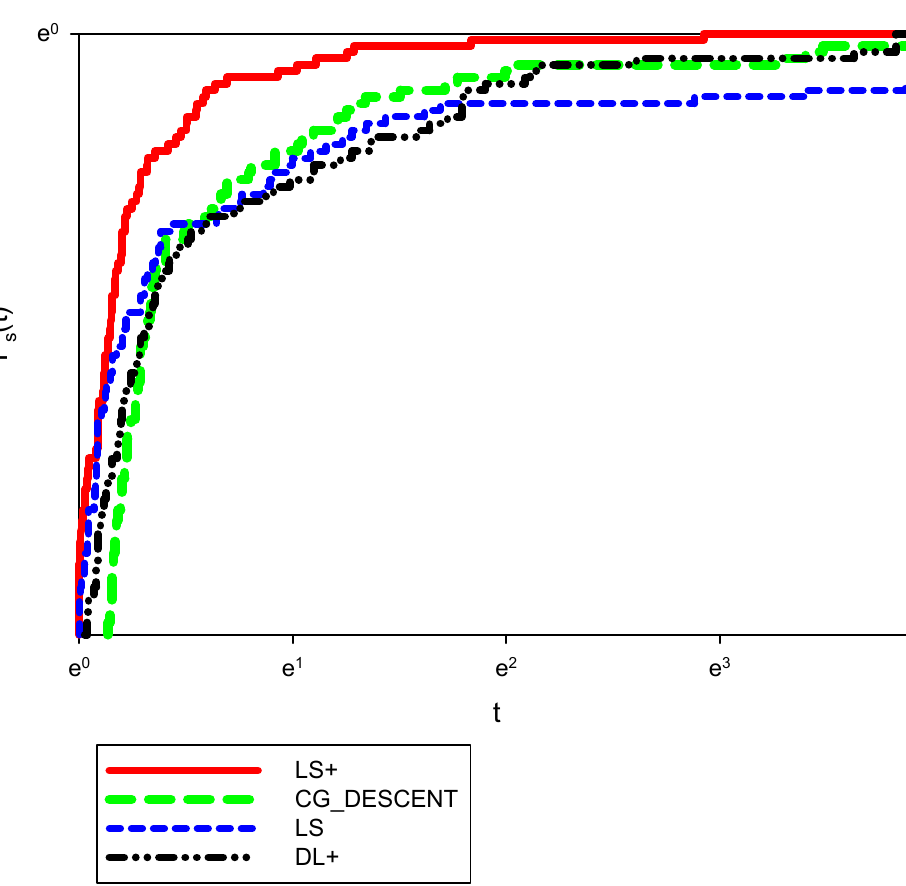
Figure 1. Performance measure based on the number of iterations.